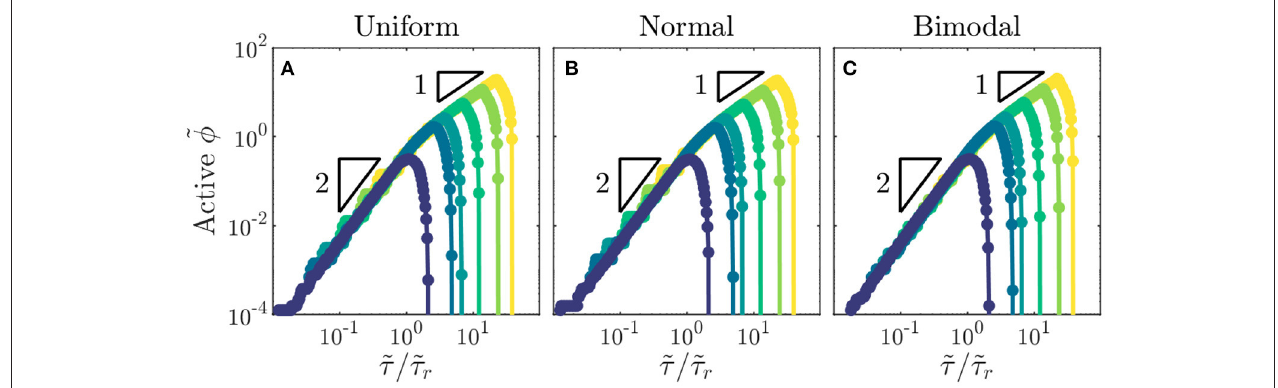
FIGURE 4 | Total fraction of active infections in a population shows general dynamics across populations with different recovery durations and distributions of individual interaction barriers. (A–C) Growth of rescaled infected